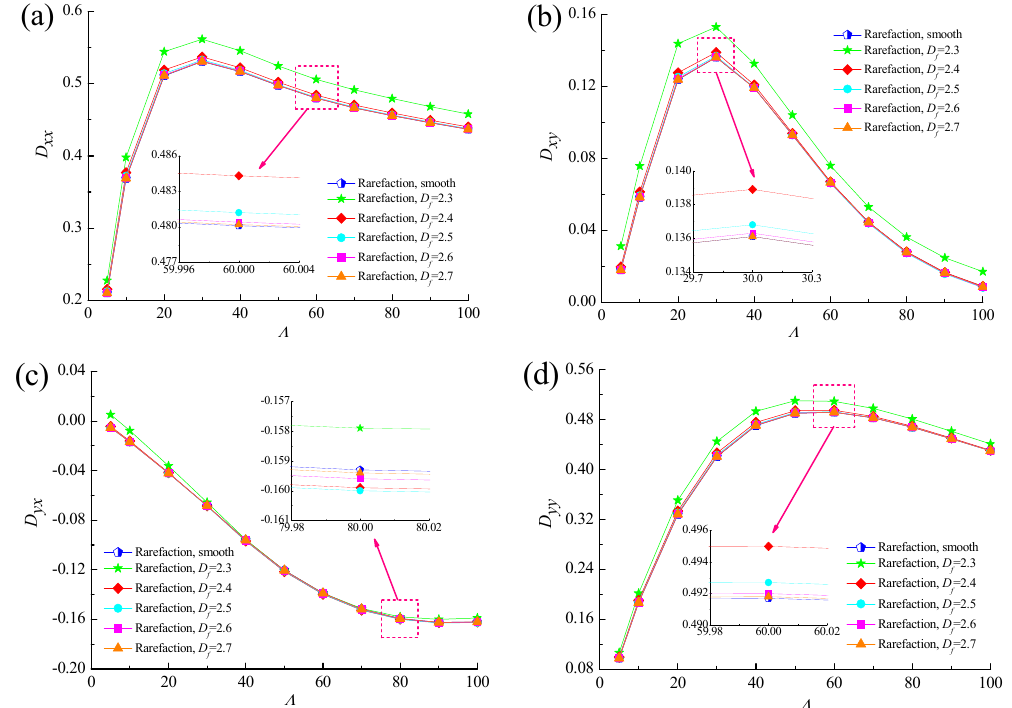
Figure 17. Effect of bearing number on dynamic damping coefficients with different fractal dimensions. ( a ) D xx vs. Λ ; ( b ) D xy vs. Λ ; ( c ) D yx vs. Λ ; ( d ) D yy vs. Λ